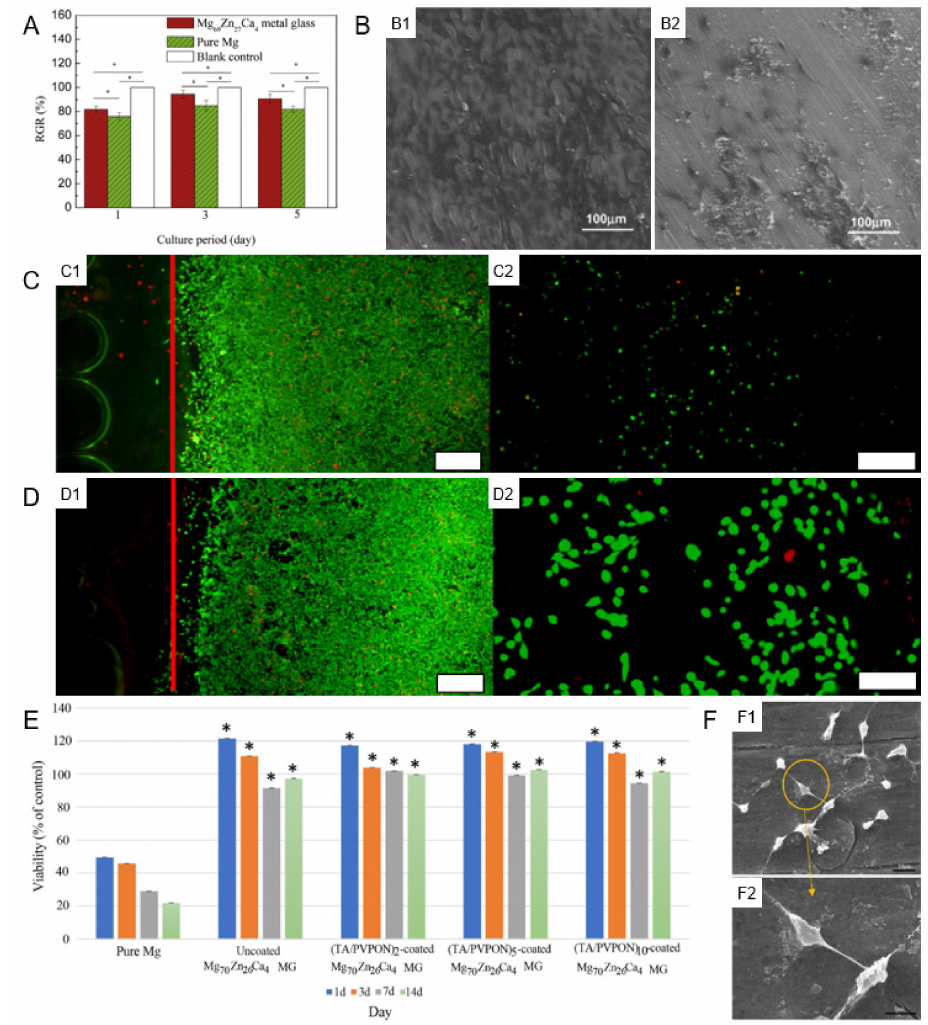
Figure 4. Cellar biocompatibility of Mg–Zn–Ca-based MGs. ( A ) Cell viability after incubation with different extracts for 1, 3, and 5 days, * p < 0.05, reproduced with permission from [54]. ( B ) The